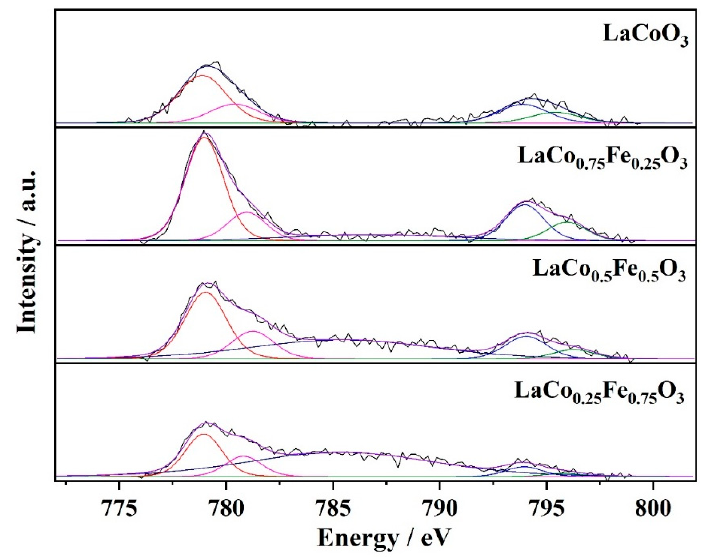
Figure 12. XPS spectra of Co2p post-reaction.